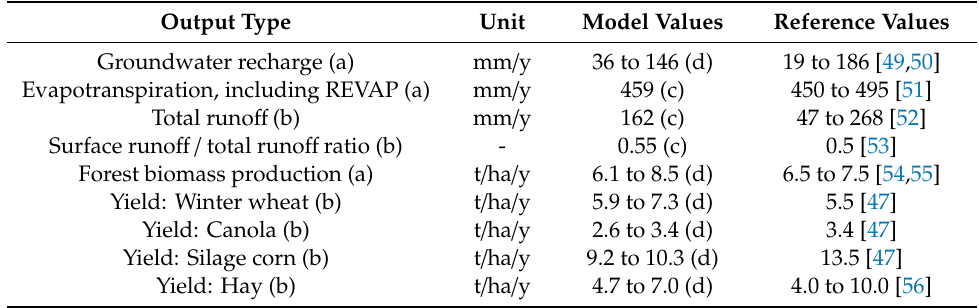
Table 1. Comparison of calibrated model outputs with reference values (a: Calibration goals, b: Validation checks, c: Average for the whole model area, d: Variability range depending on 353 hydrological response units (HRU)